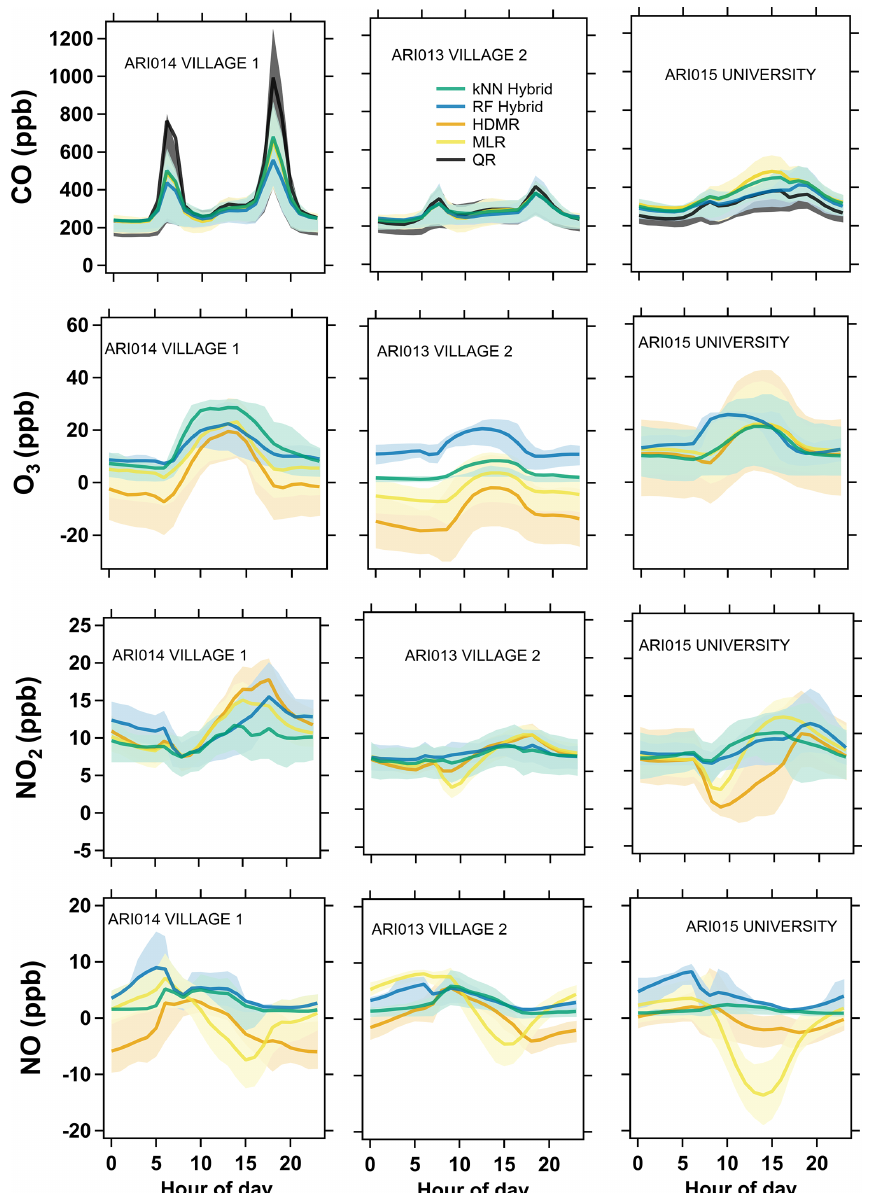
Figure 6. Diurnal trends of calibrated gas measurements (rows) at each site (columns) in the three deployment environments. RF hybrid stands for random forest hybrid, k NN hybrid stands for k -nearest neighbors hybrid, HDMR stands for high dimensional model representation, MLR stands for multilinear regression, and QR stands for quadratic regression QR model built for and applied to CO data only. The thick line indicates hourly mean, and the shaded region indicates interquartile range. Midnight is the zero hour. The hours are in local